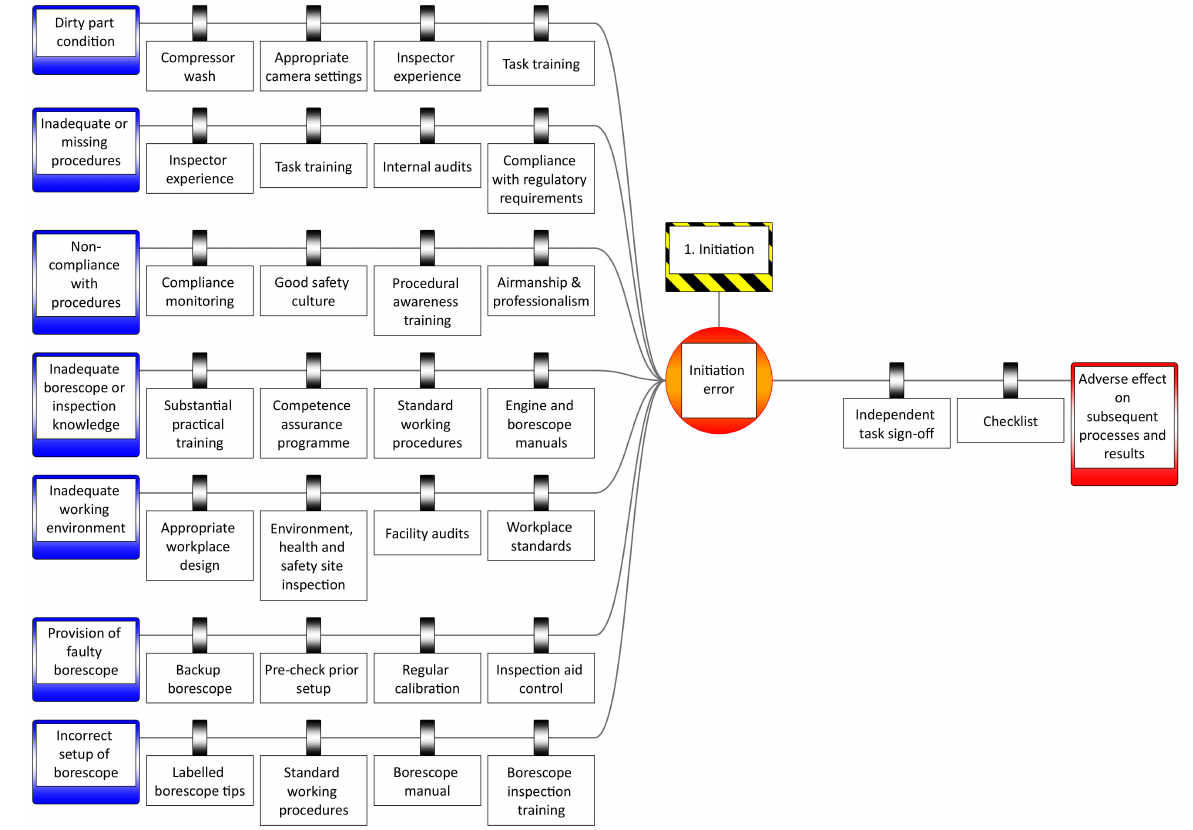
Figure 27. Exemplary Bowtie Diagram for the first step of the inspection